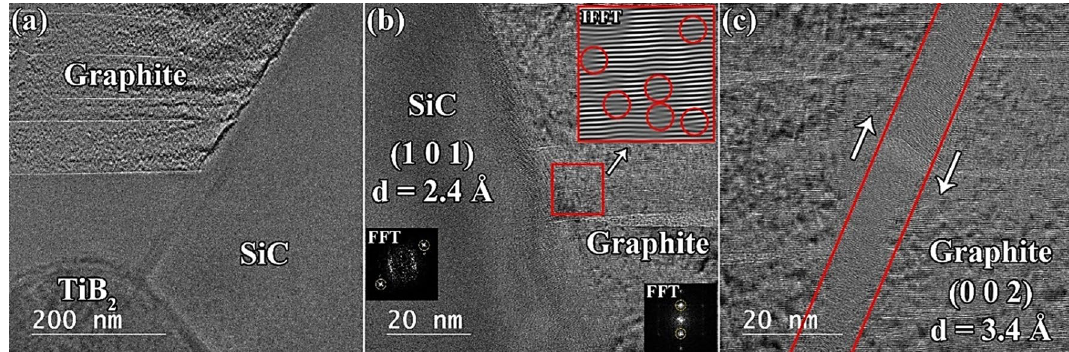
Figure 10. ( a ) TEM image of C f -incorporated TiB 2 –SiC composite showing TiB 2 , SiC, and graphite compounds. ( b ) HRTEM of the SiC/graphite interface. (c) HRTEM of the deformed graphite nanosheets. Phases Elastic modulus (GPa) Hardness